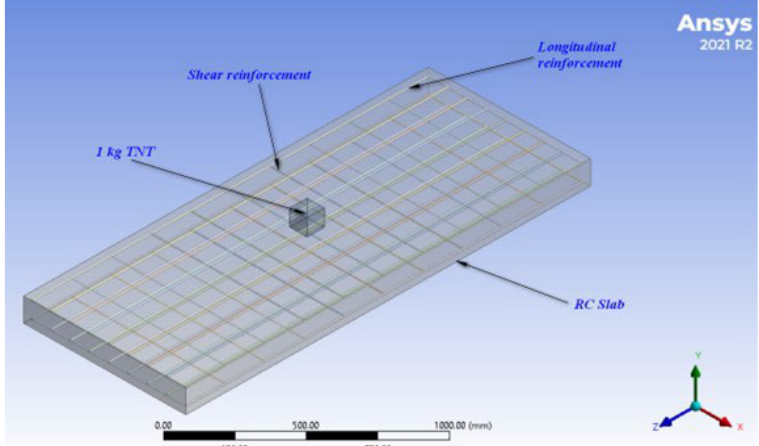
Figure 4- Geometry model of the reinforcement discrete line bodies(beam elements) embedded within the concrete slab solid body of the slab specimens under contact explosion tested by Li et al.